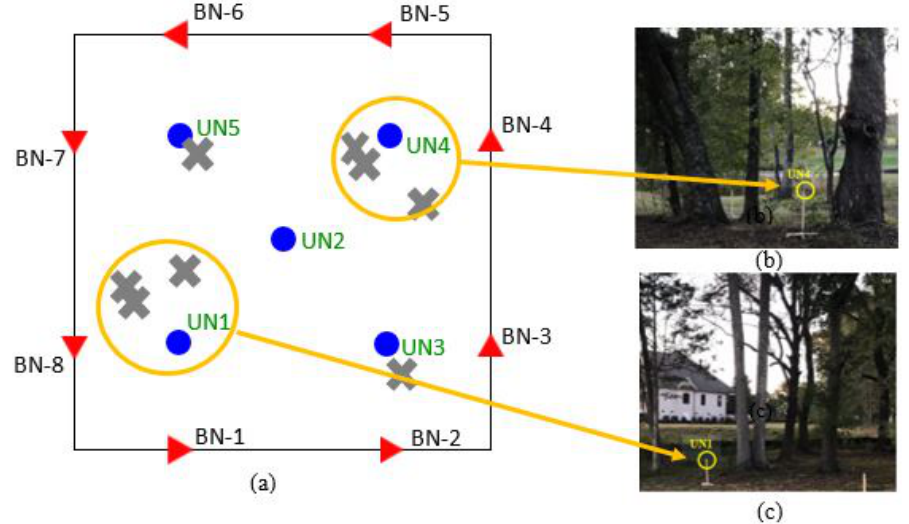
Figure 17. ( a ) Off campus experimental testbed layout showing BNs (red triangles), UNs (blue circles) and trees as obstacles (gray crosses), ( b , c ) show UN1 and UN4 obstructed by cluster of trees